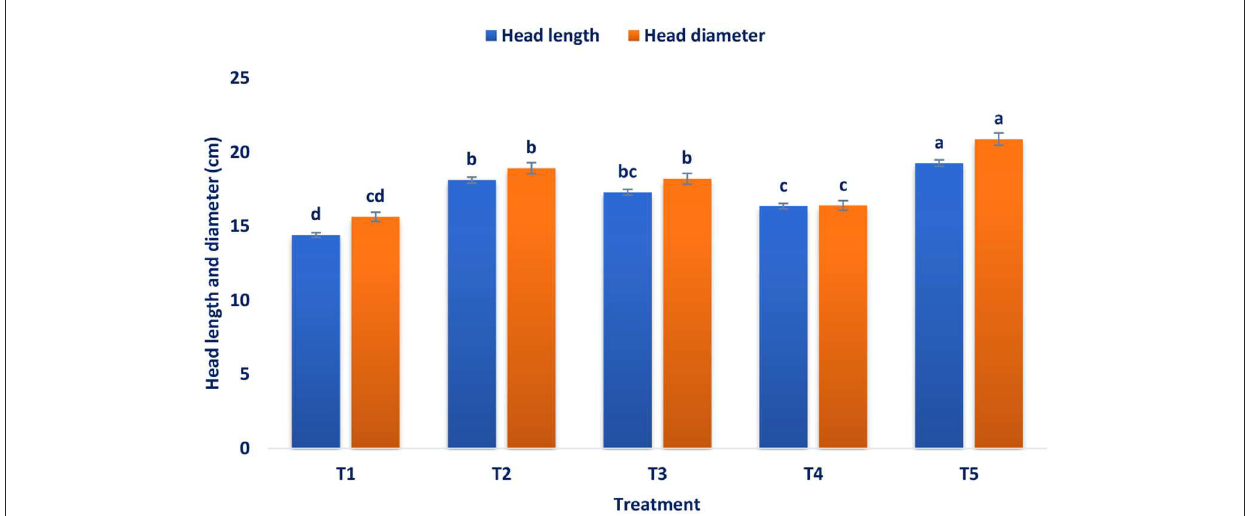
FIGURE1 Influence of pre-harvest foliar application of mineral nutrients on the head length and diameter of broccoli at the marketable stage. T 1 = control, T 2 = B, T 3 = Zn, T 4 = Mo, and T 5 = B + Zn + Mo, 0.40%, respectively.